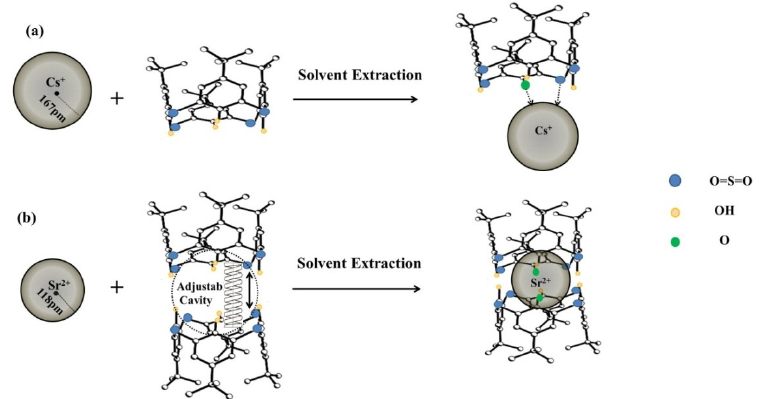
Figure 8. ( a ): Extraction mechanism of Cs(I) with SC4A from aqueous solution; ( b ): Extraction mechanism of Sr(II) with SC4A from aqueous solution.